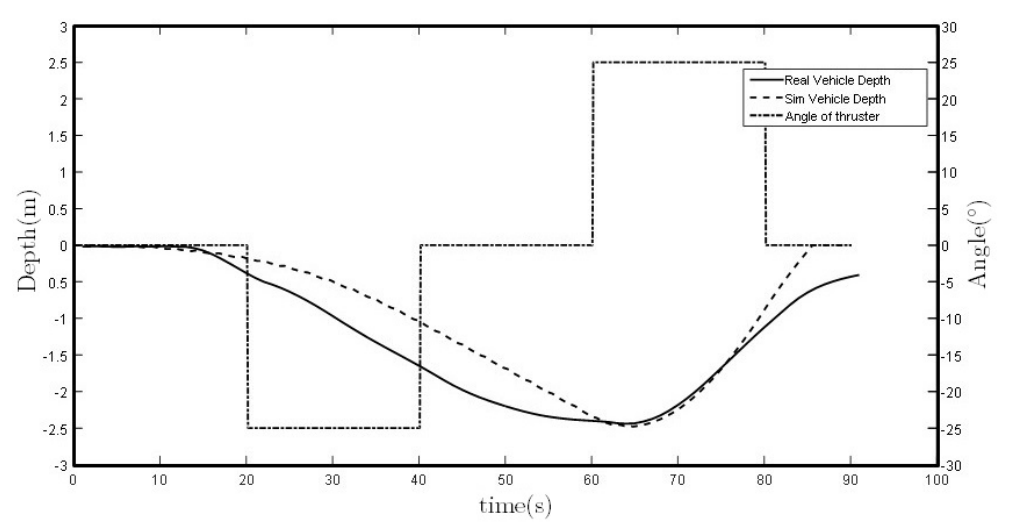
Figure 23. Vehicle’s vertical plane trajectory performance comparison between simulation and field